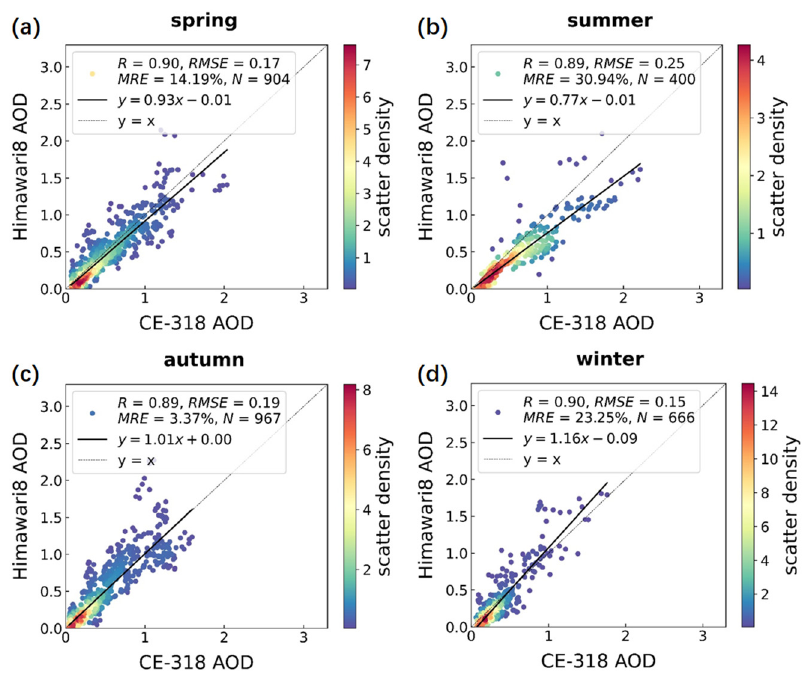
Figure 6. AHI AOD inversions were evaluated for the different seasons of spring ( a ), summer ( b ), fall ( c ), and winter ( d ) during the August 2017 to March 2019 period, using the Gucheng sun photometer AOD as a benchmark.